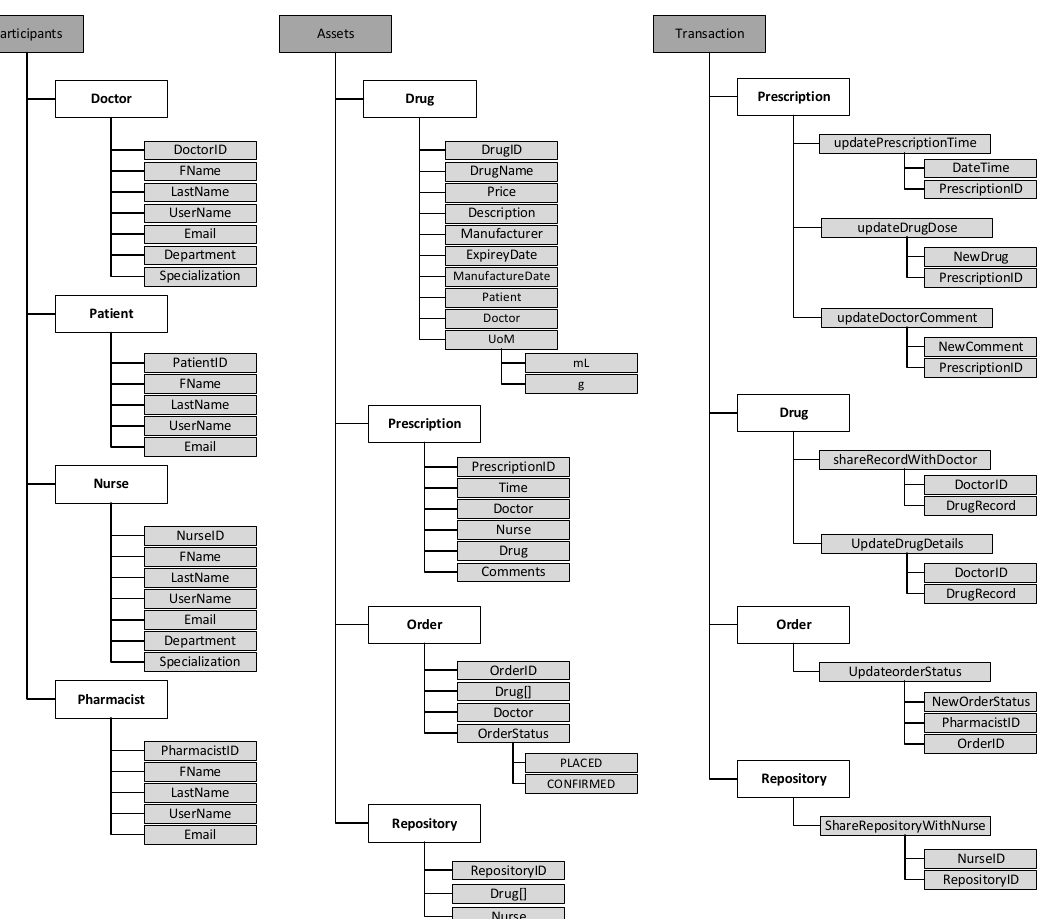
Figure 9. Hyperledger Fabric-based business network for the proposed